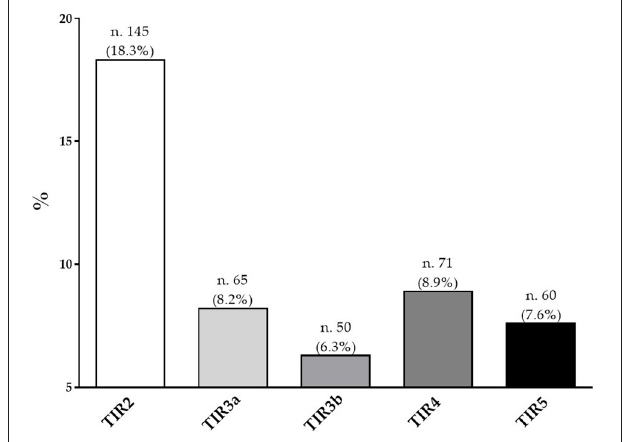
FIGURE 1 | Percentage of the five diagnostic cytology categories based on 2013 Italian thyroid cytology classification system. associated with all categorical variables ( p < 0.001), except gender ( p = 0.206) and grade I obesity ( p = 0.815). In particular, the presence of thyroid nodular disease was associated with smoking (OR 3.76, p < 0.001), physically inactive subjects (OR 0.28, p < 0.001), the BMI classes, and the lowest adherence to the MD (OR 6.16, p < 0.001).